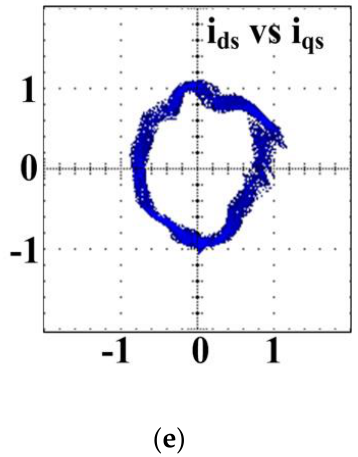
Figure 8. d-q current in amp (both the scale is in amperes) under ( a ) Healthy operation; ( b ) 1-Ph open circuit fault without control strategy; ( c ) A2-Ph open circuit fault without control strategy; ( d ) 1-Ph open circuit fault with control strategy; ( e ) A2-Ph open circuit fault with control